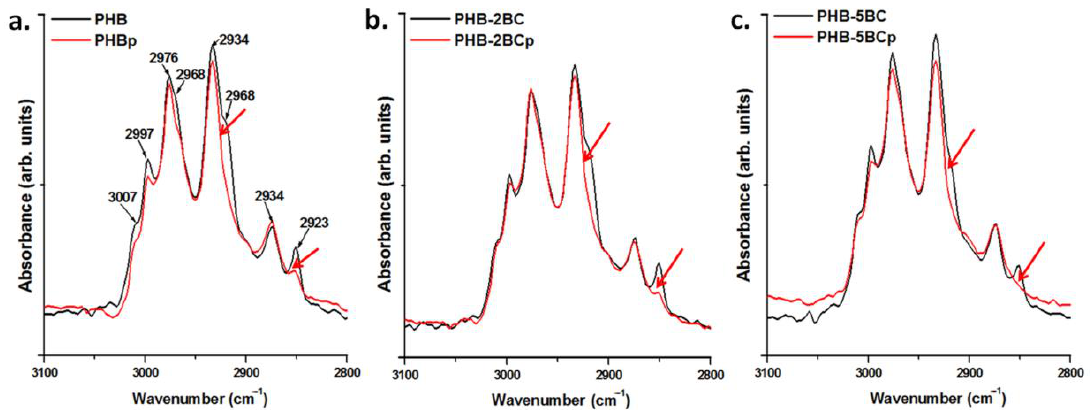
Figure 4. FTIR spectra of untreated and plasma-treated PHB and nanocomposites in the C–H stretching vibration region.